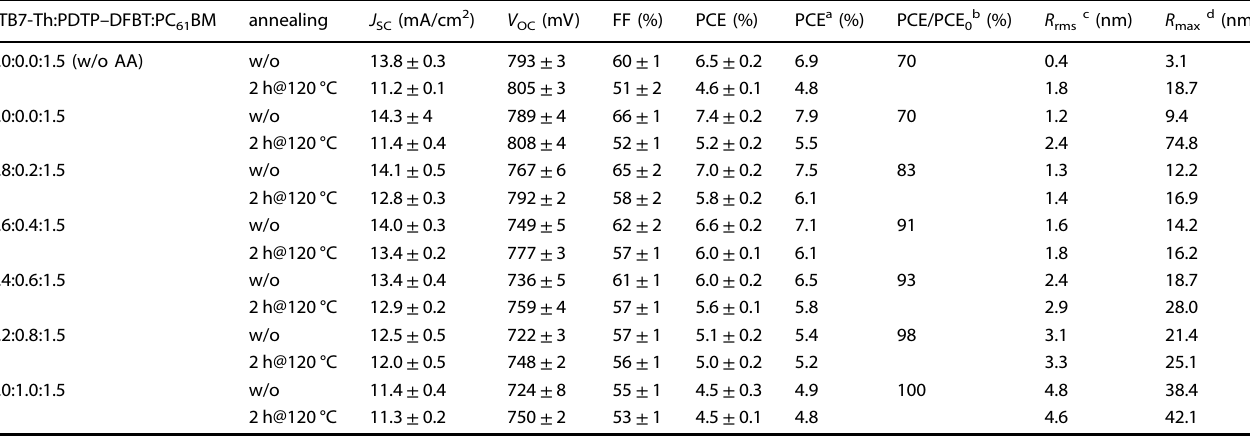
Table 1. Key performance parameters of solar cells comprising PTB7-Th:PDTP – DFBT:PC 61 BM ([1- x ]: x :1.5 w/w/w) light harvesting layers before and after thermal annealing (120 °C, 2 h). The data set represents more than 20 samples per entry PTB7-Th:PDTP – DFBT:PC 61